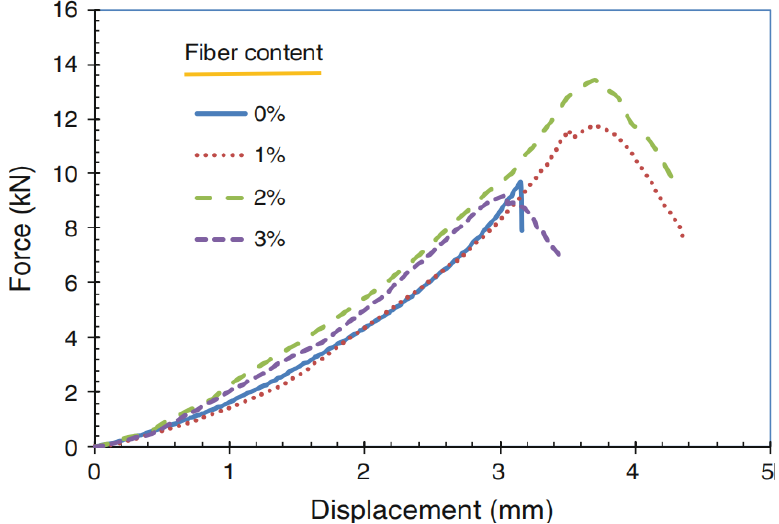
Figure 11. Load and displacement curves of sweet sorghum PFRGs in splitting tensile test